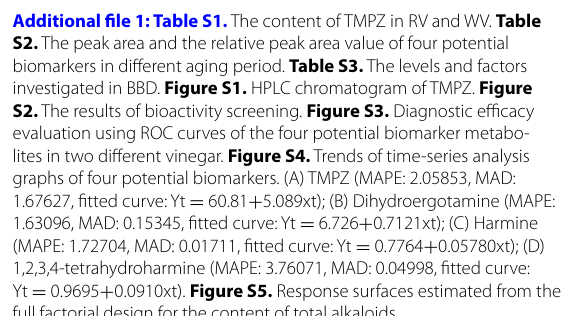
Additional file 1: Table S1. The content of TMPZ in RV and WV. Table S2. The peak area and the relative peak area value of four potential biomarkers in different aging period. Table S3. The levels and factors investigated in BBD. Figure S1. HPLC chromatogram of TMPZ. Figure S2. The results of bioactivity screening. Figure S3. Diagnostic efficacy evaluation using ROC curves of the four potential biomarker metabo- lites in two different vinegar. Figure S4. Trends of time-series analysis graphs of four potential biomarkers. (A) TMPZ (MAPE: 2.05853, MAD: 1.67627, fitted curve: Yt 60.81 5.089xt); (B) Dihydroergotamine (MAPE: = + 1.63096, MAD: 0.15345, fitted curve: Yt 6.726 0.7121xt); (C) Harmine = + (MAPE: 1.72704, MAD: 0.01711, fitted curve: Yt 0.7764 0.05780xt); (D) = + 1,2,3,4-tetrahydroharmine (MAPE: 3.76071, MAD: 0.04998, fitted curve: Yt 0.9695 0.0910xt). Figure S5. Response surfaces estimated from the = + full factorial design for the content of total